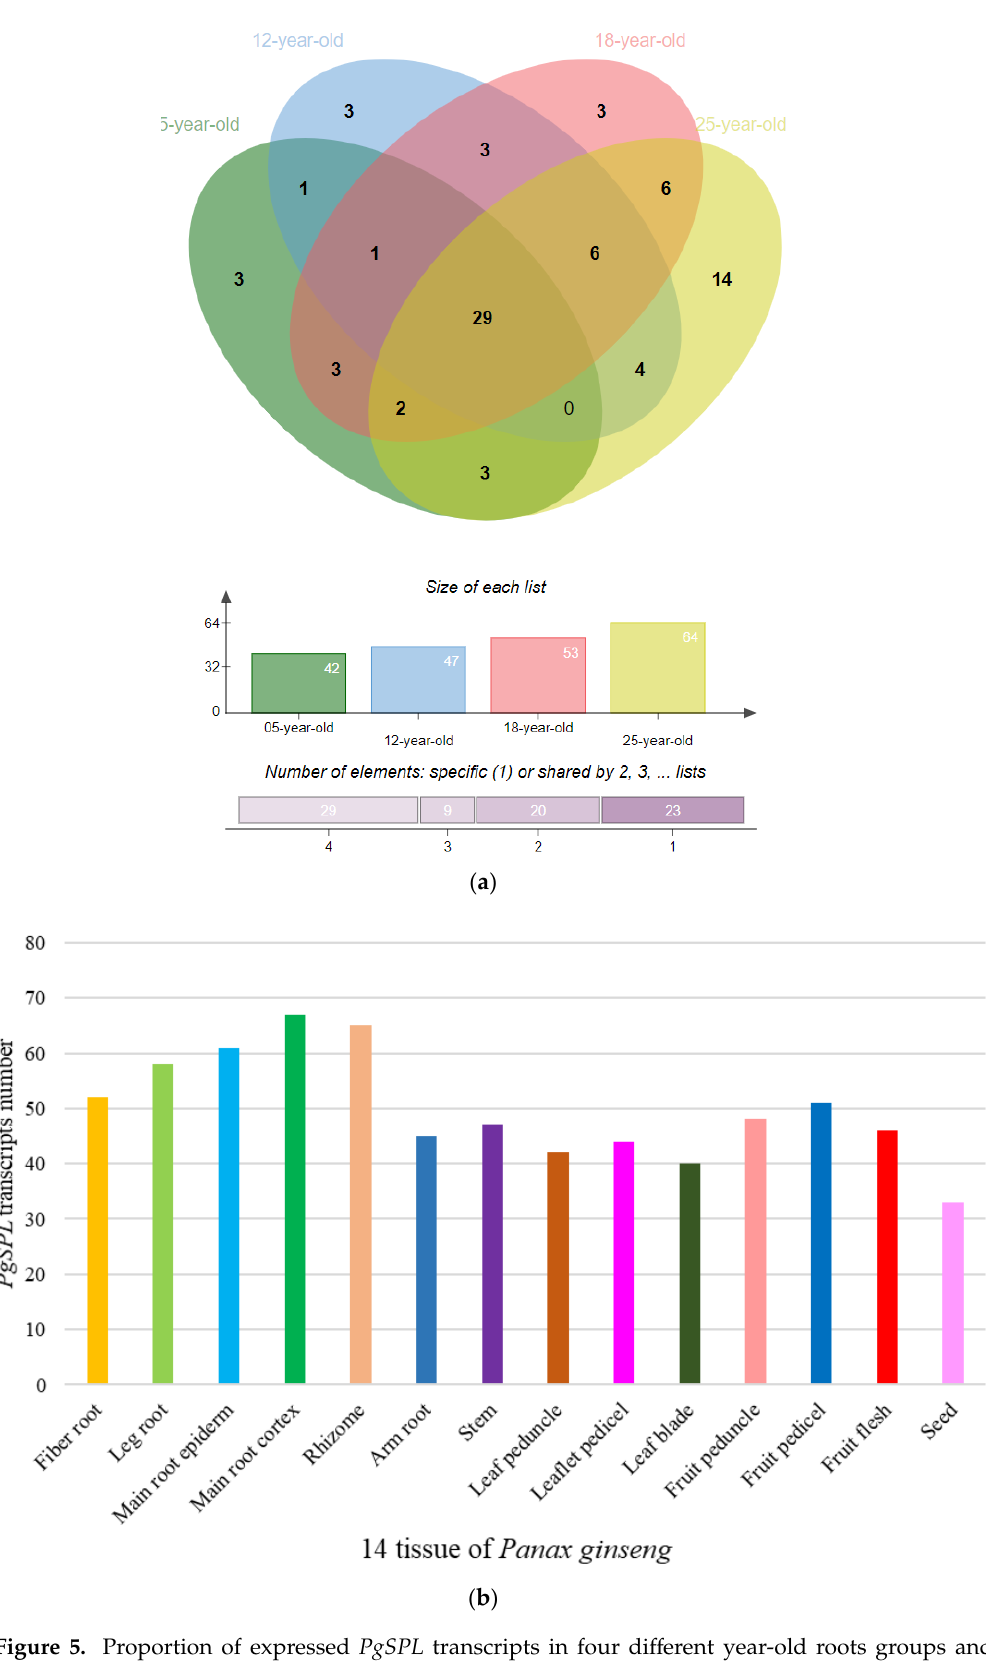
Figure 5. Proportion of expressed PgSPL transcripts in four di ff erent year-old roots groups and 14 tissues. ( a ) The Venn chart of the numbers of 81 PgSPL transcripts expressed in four age groups. ( b ) The histogram of 96 PgSPL transcripts expressed in 14